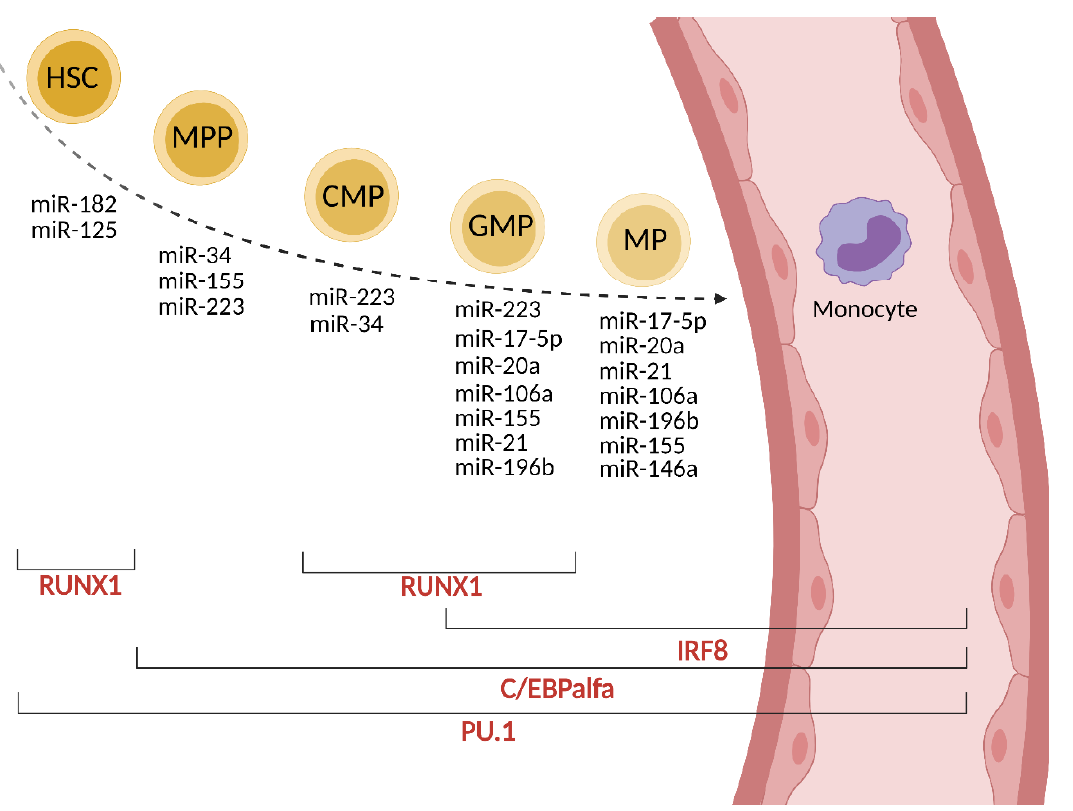
Figure 1. miRNA and transcription factors involved in monocyte formation.